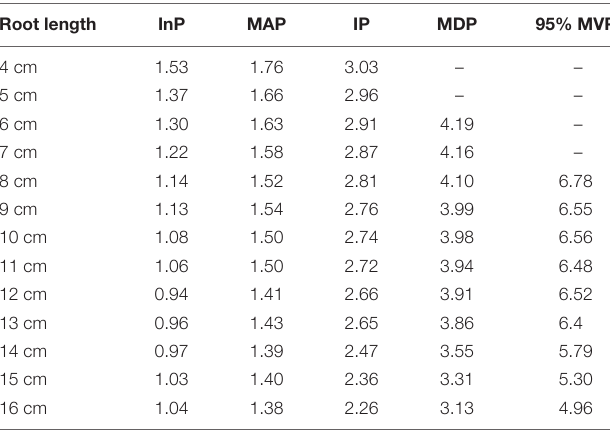
TABLE 1 | The abscissa values (distance from the root apex) of the critical points for the Ti-Gompertz model. Root